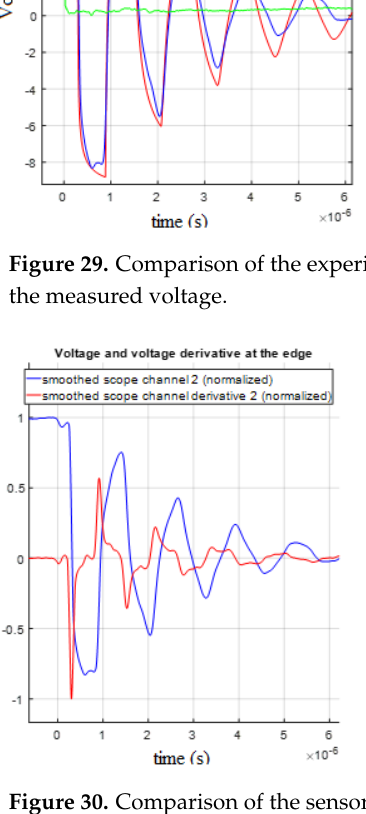
Figure 30. Comparison of the sensor voltage and its